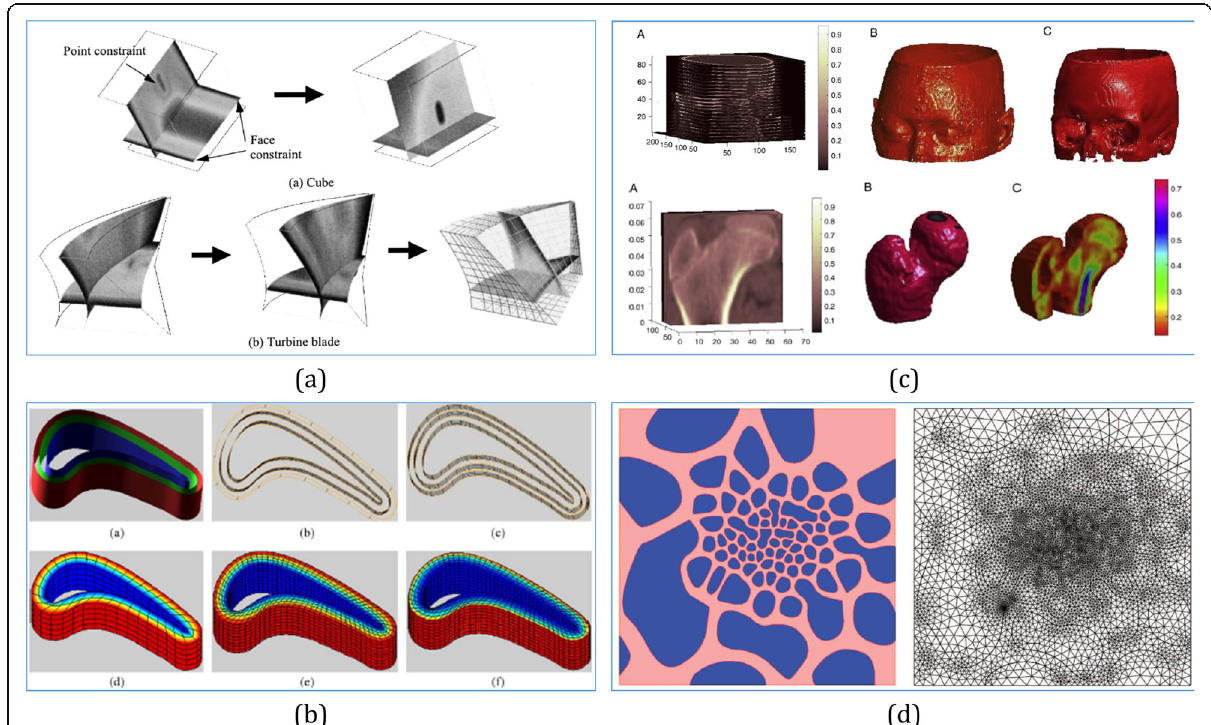
the distribution values in the control mesh [59]. d Microstructural model of an FGM with graded volume fractions based on the stochastic Voronoi diagram and B-spline representation [60, 61]